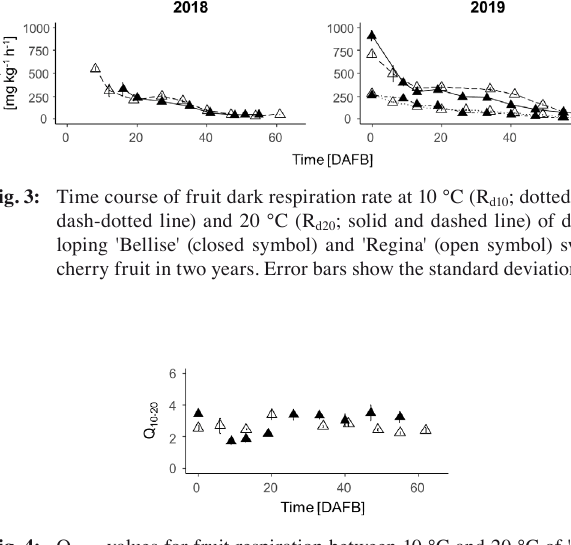
Fig. 4: Q 10-20 values for fruit respiration between 10 °C and 20 °C of 'Bel- lise' (closed symbol) and 'Regina' (open symbol) cherries during fruit development in 2019. Error bars show the standard deviation.